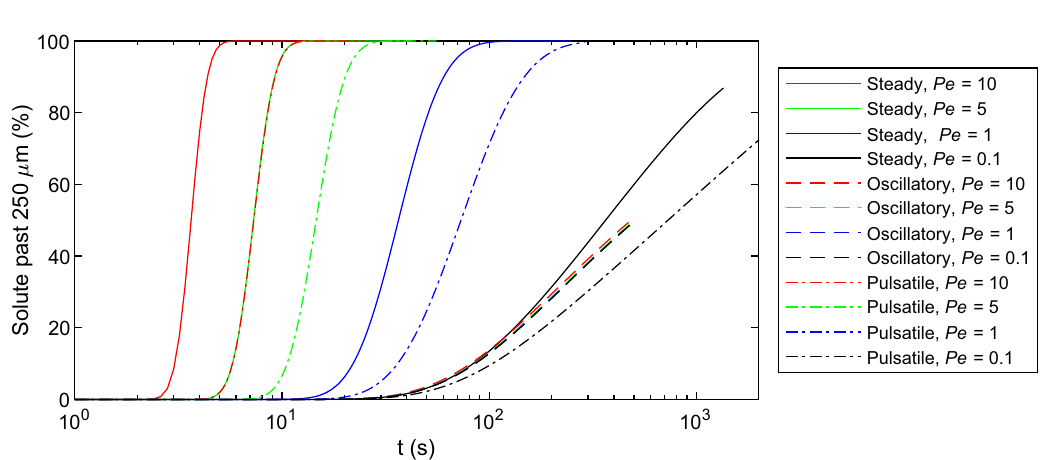
Figure 5. Clearance times for a given percentage of total solute to travel axially more than 250 µ m to the right, from the center of the initial bolus of solute. Steeper slopes indicate more effective solute clearance. For z ) was included, meaning effective directional transport is half oscillatory flows, transport in both directions ( ± the value plotted